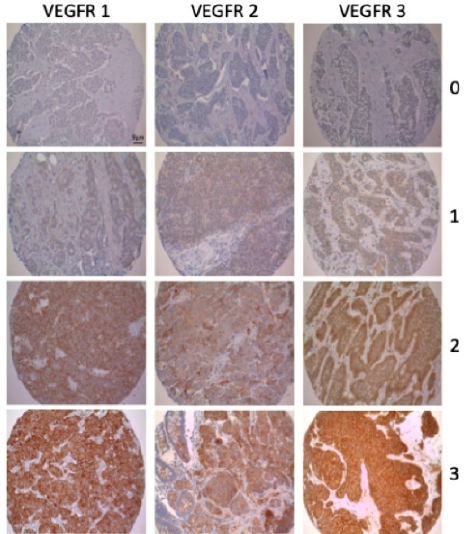
Figure 1. Examples of the immunohistochemical evaluation of VEGFR 1-3 (10× magnification): 0 = negative; 1 = weakly positive; 2 = moderately positive; 3 = strongly